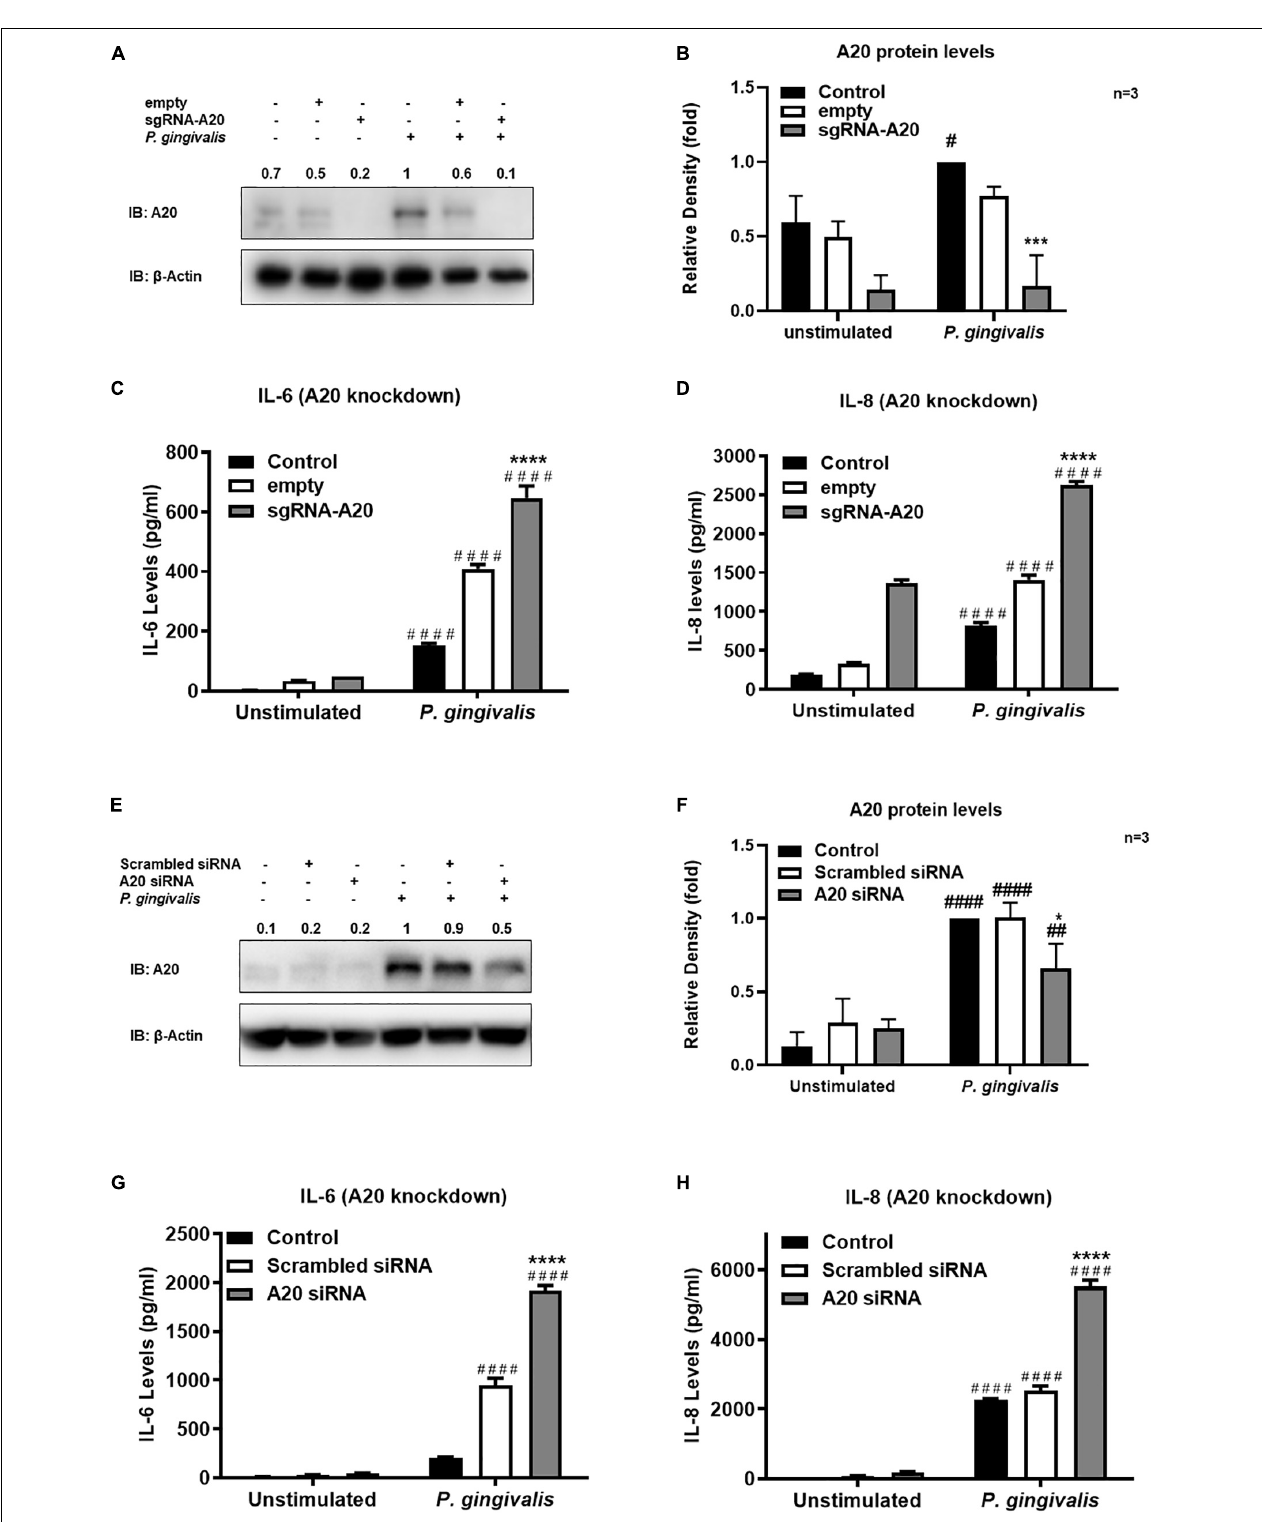
FIGURE 2 | A20 depletion increases inflammatory cytokine production in human gingival keratinocytes. ELISA assays detecting cytokine production of TIGKs with depleted A20 expression or control cells infected with P. gingivalis . TIGKs with lentivirus containing sgRNA targeting A20 (sgRNA-A20) or empty vector (empty) were infected with P. gingivalis (100 MOI) for 6 h. Cells were lyzed for indicated protein levels, represent Western blots were shown (A) . Relative protein levels for three